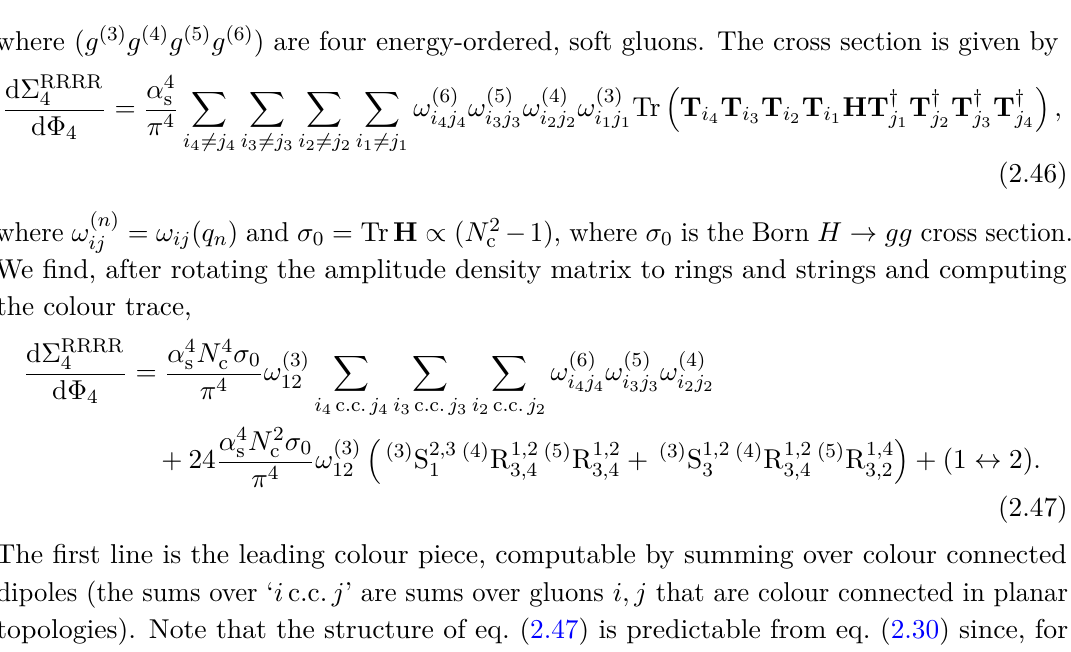
Figure 2 . The three and four emission contributions to the soft gluon evolution of h → gg in the gaps-between-jets observable (including virtual corrections). The green line indicates the leading colour contribution, which agrees between the two sampling strategies. The violet curve uses only dipoles to generate each emission, while the blue curve corresponds to summing dipoles to form rings where appropriate. All runs have the same (deliberately low) statistics to illustrate the